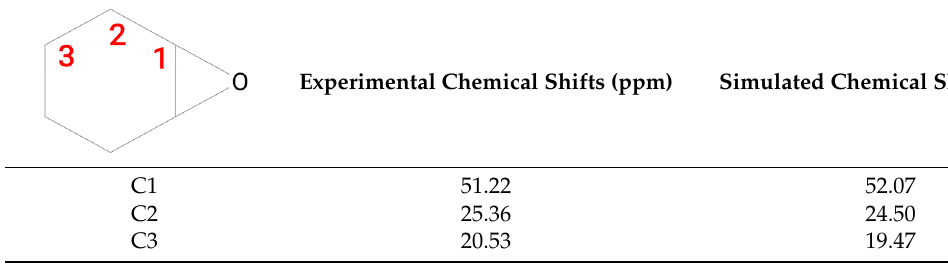
Table 2. Experimental and simulated chemical displacement values for epoxide carbon.